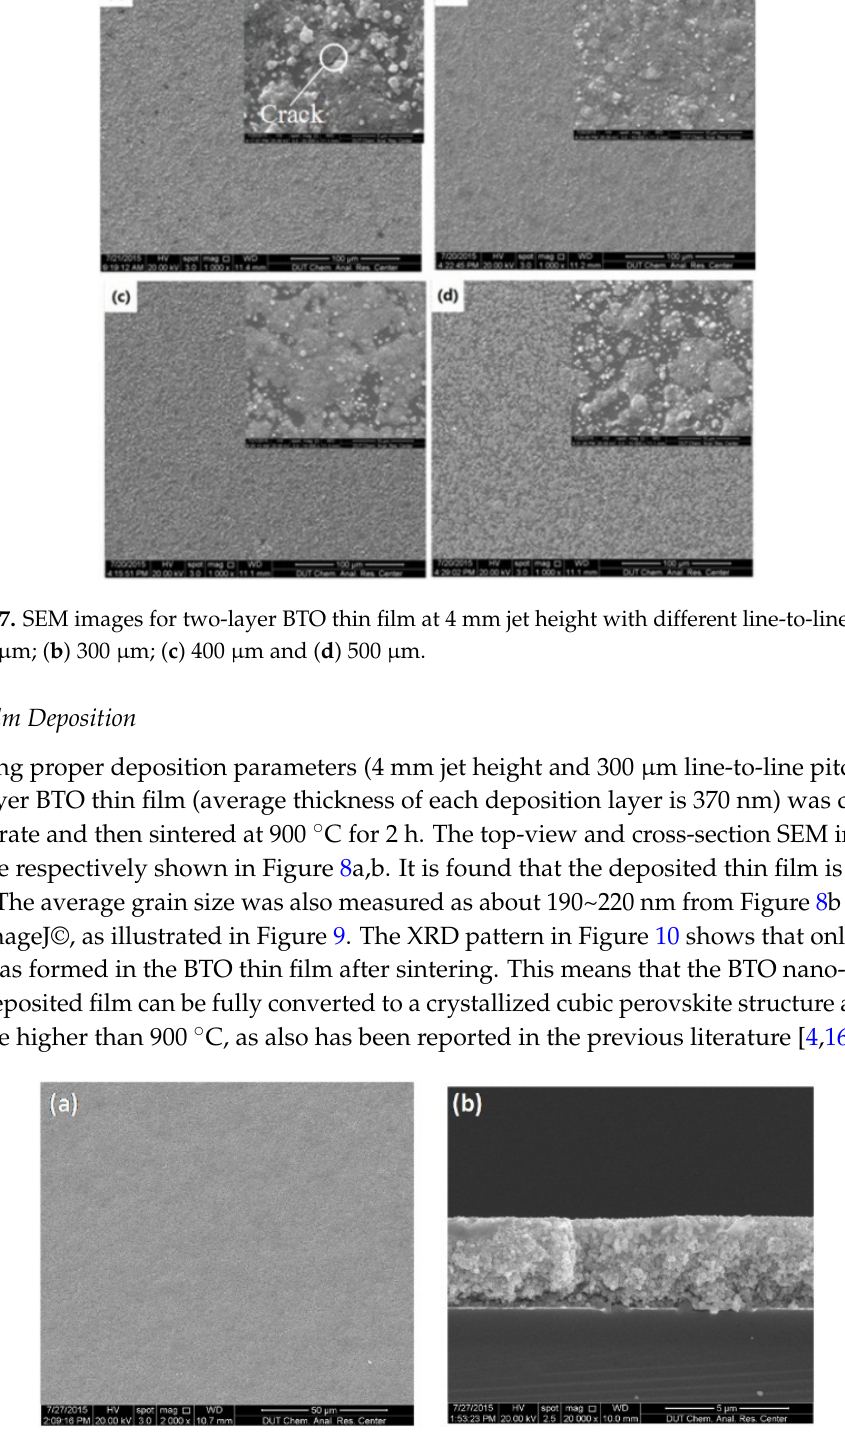
Figure 8. SEM images for 10 ‐ layer BTO thin film prepared with 4 mm jet height and 300 μ m line ‐ to ‐ line pitch: ( a ) top ‐ view, ( b ) cross ‐ section view.